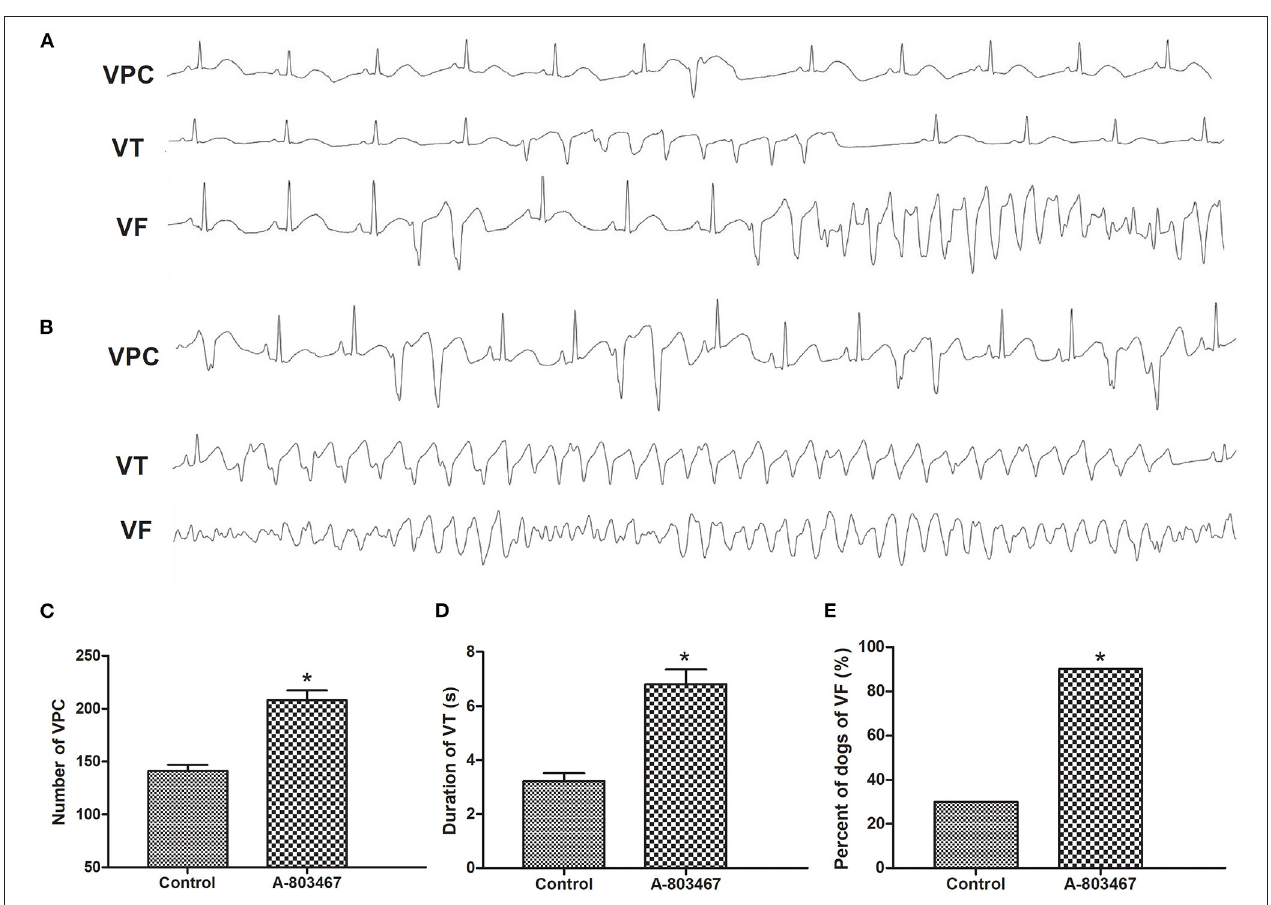
FIGURE 3 | The occurrence of ventricular arrhythmias during 1h after LAD occlusion. Representative examples of the ventricular premature contraction (VPC), ventricular tachycardia (VT), and ventricular fibrillation (VF) ECG tracings (lead II) in the Control group (A) and the A-803467 group (B) . (C) VPCs were markedly increased in the A-803467 group after LAD occlusion compared to Control. (D) The mean duration of VT was longer in the A-803467 group after LAD occlusion compared to Control. (E) Percentage of dogs with VF was apparently increased in the A-803467 group after LAD occlusion compared to Control. * P < 0.05 vs. Control group.